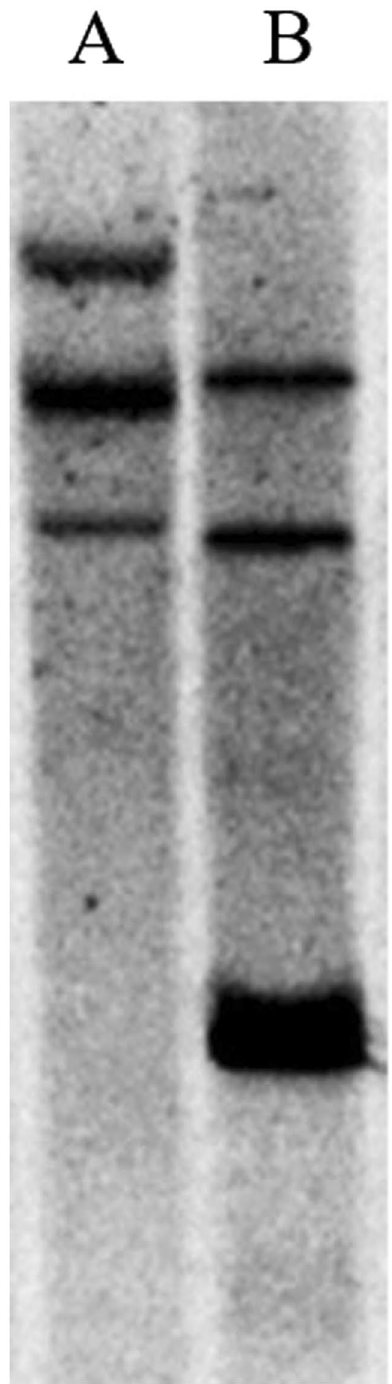
Figure 4. Southern blot analysis to determine TaARG copy number in the common wheat genome. ( A ) Bam HI-digested genomic DNA of CB037; ( B ) Kpn I-digested genomic DNA of CB037. acquisition tools and image processing software package. The photo was acquired by Tanon 5200 software (YPH-bio, Co. Ltd. Beijing,